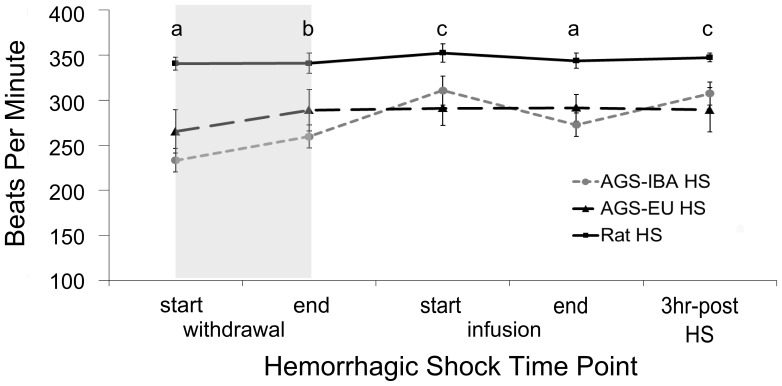
Rats have a higher average heart rate before, during and after hemorrhagic shock than AGS.Shaded region indicates period of hemorrhage. Rats differed from both AGS groups (a, Tukey, p<0.05), just the AGS-IBA (b, Tukey, p<0.05), or AGS-EU (c, Tukey p<0.05). AGS-EU and –IBA did not differ from each other at any timepoint. Data shown as mean±SEM, n = 6–7 for all treatment groups.